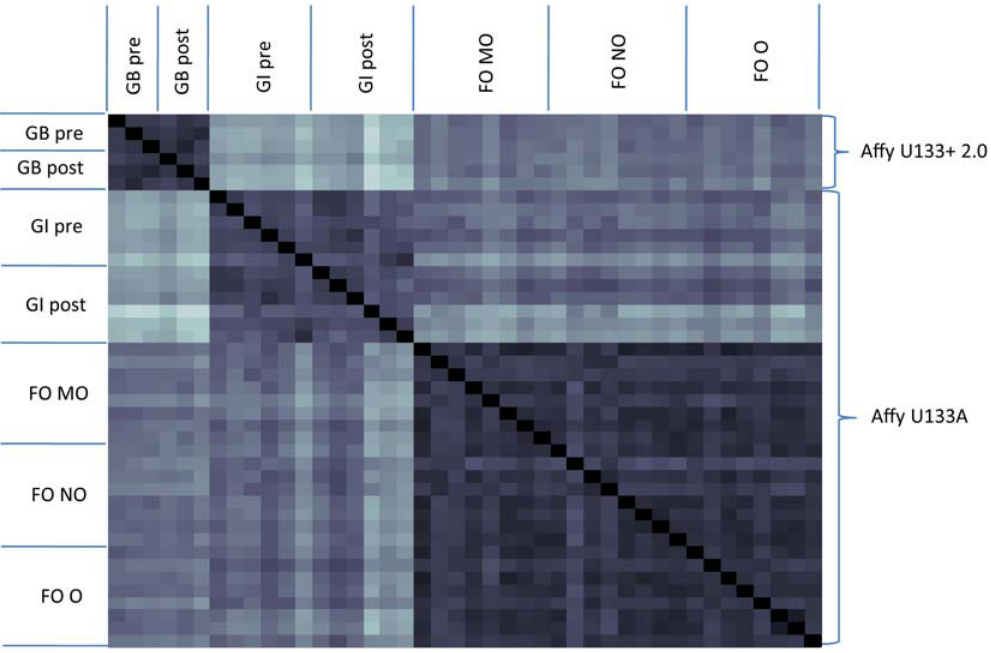
Figure 11. A comparison of skeletal muscle models, using only reactions that have data for both gene chips used. This figure is the same as Figure 10, but the distances that are graphically represented are computed using only reactions that have data on both types of gene chips. The 5% of reactions that are represented on the U133 + 2.0 chip but not the U133A chip are not used for comparison. Here we no longer see any bias based on chip type, but rather we see that the FO datasets appear to be similar to both GI and GB data sets, instead of just the GI data sets. The chip type does not appear to affect the distances as much as the different experiments do. The chip type does appear to affect the reactions that the algorithm defines as active versus inactive, as seen in the differences between Figures 10 and